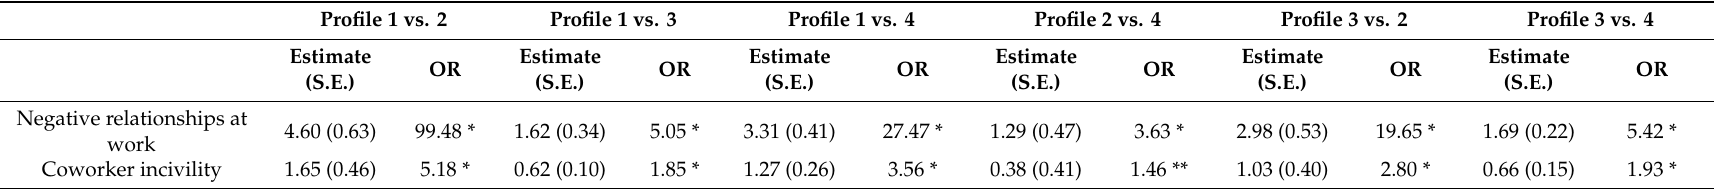
Table 3. The three-step procedure results for antecedents